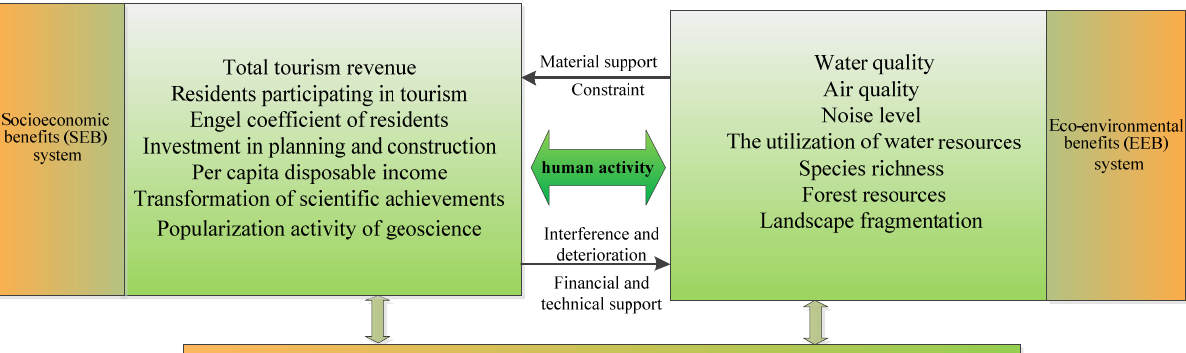
Figure 3. Complex system of SEBs and EEBs of Global Geoparks.